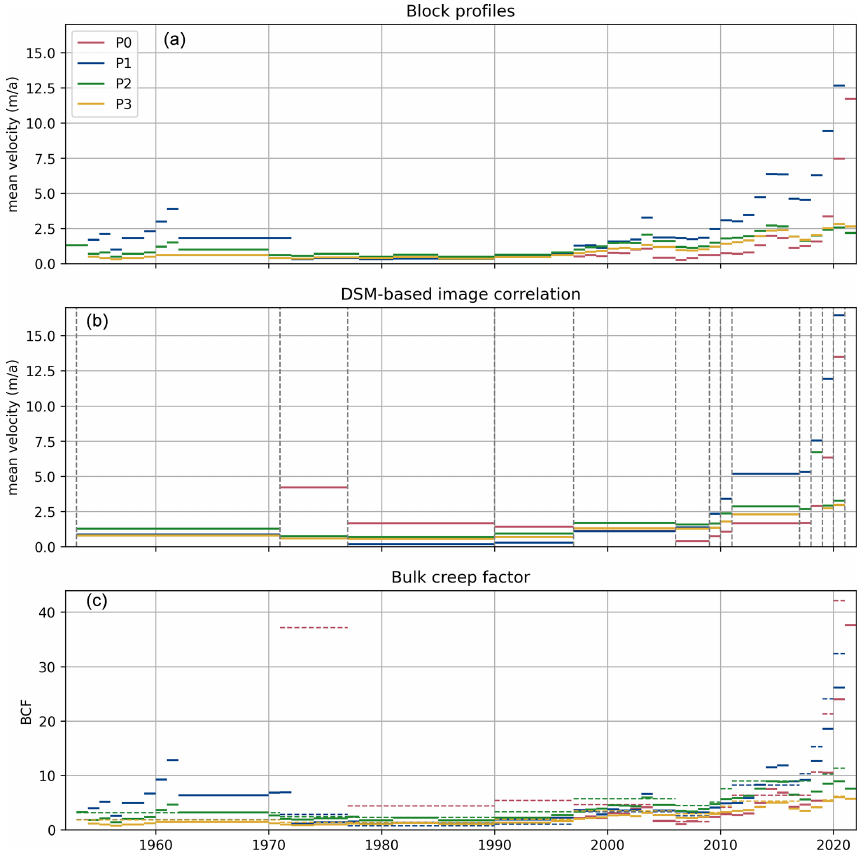
Figure 5. Time series of (a) mean profile velocities (ma − 1 ) at the four block profiles (uncertainty estimate for the block profiles: ± 0 . 2– ± 0 . 5ma − 1 depending on the year; see Hartl et al., 2016b). The 2022 value not shown for P1 due to the loss of numerous blocks. (b) Mean velocities at the locations of the stone profiles derived from image correlation of DSM pairs, where vertical dashed lines indicate years for which DSMs are available. See Fig. 15 for corresponding boxplots of velocity uncertainties. (c) Bulk creep factor (BCF) computed for the mean block profile velocities (solid lines) and the DSM velocities (dotted